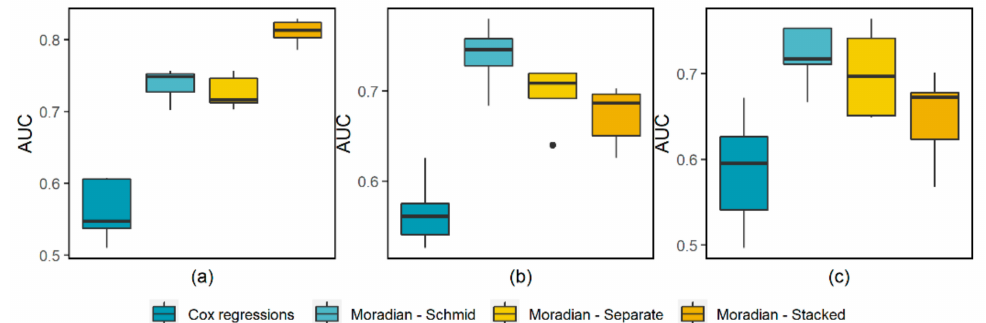
Figure 4. AUC comparison of simulated Cox regressions and random forests (N = 500) when t = 3: ( a ) AUC comparison for t = 3, u = 4; ( b ) AUC comparison for t = 3, u = 5; ( c ); AUC comparison for t = 3, u = 6.